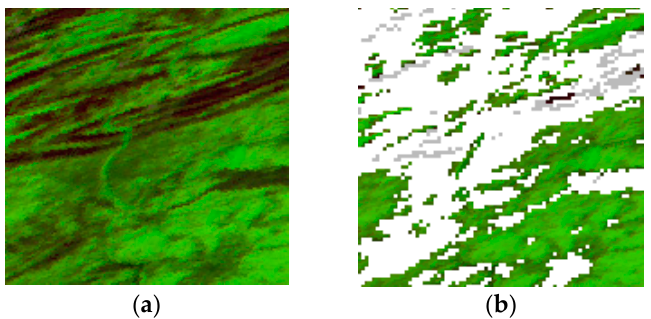
Figure 6. Shown are false color images colored in RGB according to 1.24 μ m (band 5), 0.55 μ m (band 4) and 2.1 μ m (band 7), based on MYD09GA data without ( a ) and with ( b ) NASA(Aqua) cloud mask overlay. We note that there are significantly darker patches in even fully snow covered landscape: some of these are due to terrain. Others adjacent, to the river are probably due to vegetation canopy. Consistent with the band 7 based NDSI test not being satisfied at these locations, those areas are masked as